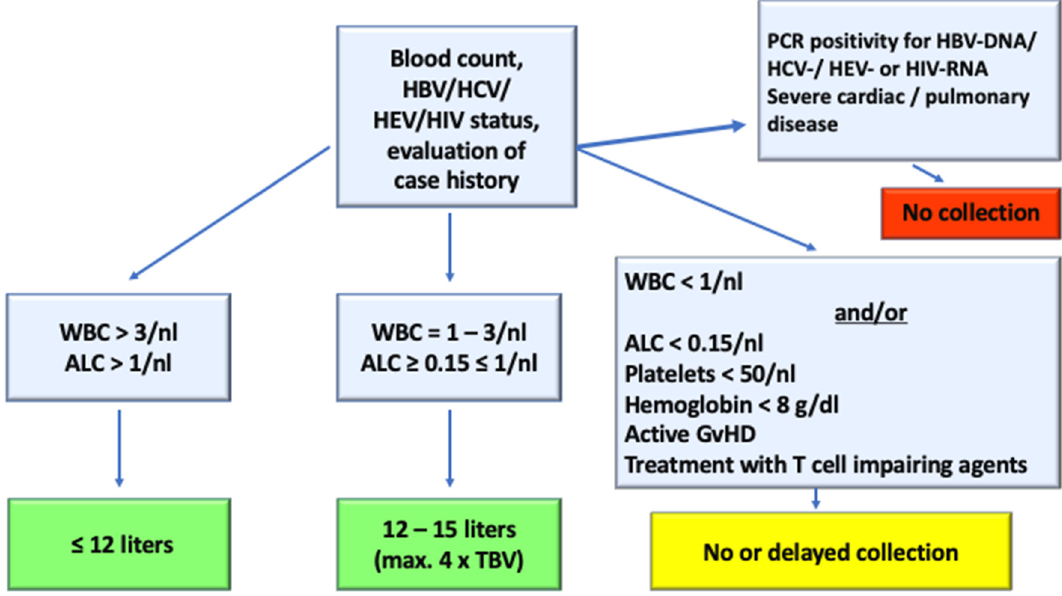
Figure 3. Apheresis algorithm towards CAR-T cell products. To increase the chance of a successful collection amount, an algorithm based on the leukocyte and lymphocyte count was created with additional listing of exclusion criteria leading to a possible cancellation or delayed collection. WBC = white blood cell count, ALC = absolute lymphocyte count, TBV = total blood volume.